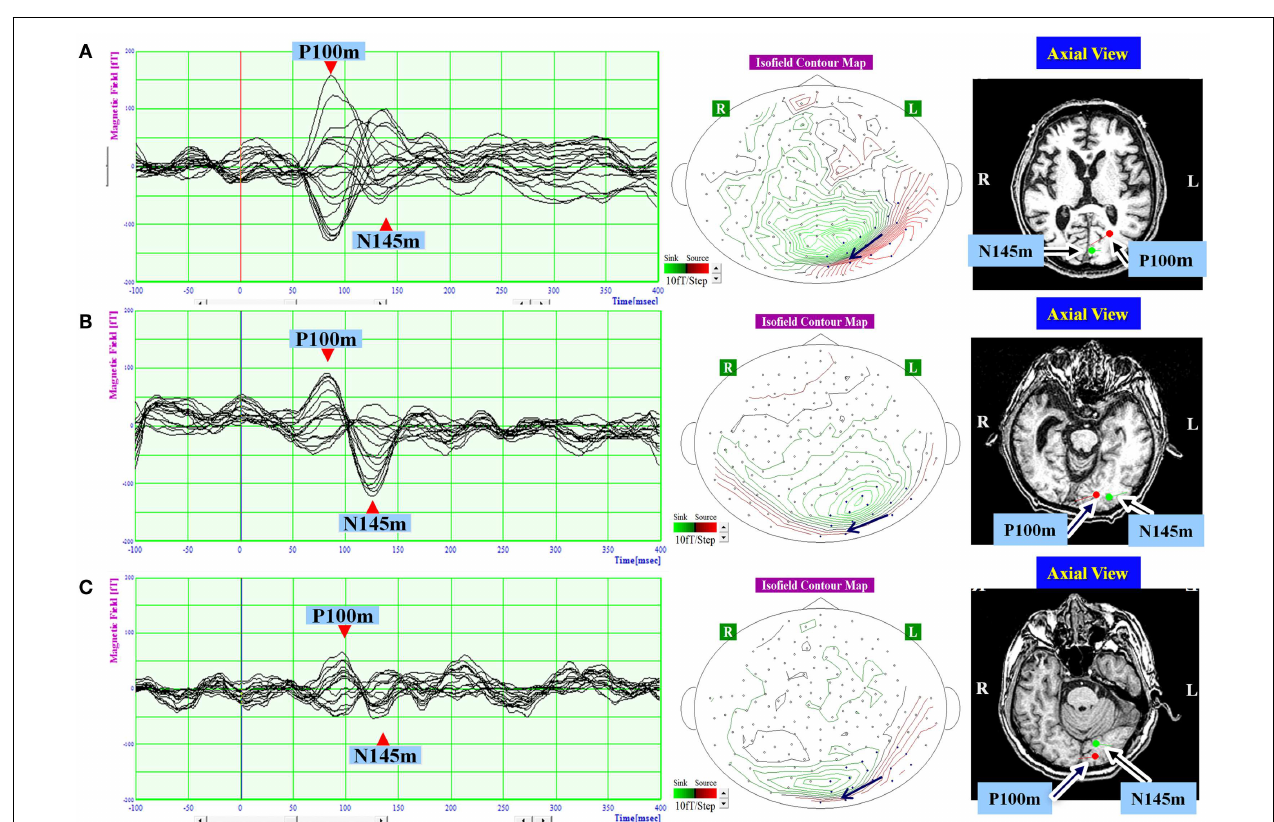
and red lines represented inward-going flux. A black arrow indicates an expected location and direction of ECD. Small circles indicate distribution of recording sensors. Blue circles indicate selected 16 channels. Right: the equivalent current dipoles (ECDs) superimposed on axial magnetic resonance images. Red represents the P100m component of theVEF; Green represents the N145m component of theVEF.The dot represents dipole location, and the bar represents dipole direction. Both components were evident and were located in occipital lobe in all patients.The P100m component was directed medially, and the N145m component was directed